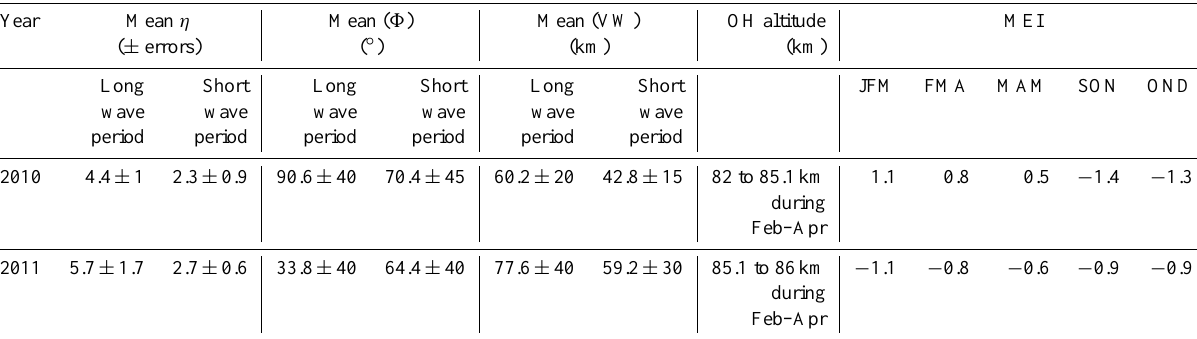
Table 1. Comparisons of deduced wave parameters in years 2010 and 2011 with the multivariate ENSO index (MEI) and OH altitudes. The observed quantities are the mean for their representative wave periods. (Abbreviations under MEI are for 3-month periods, e.g., JFM – January, February, and